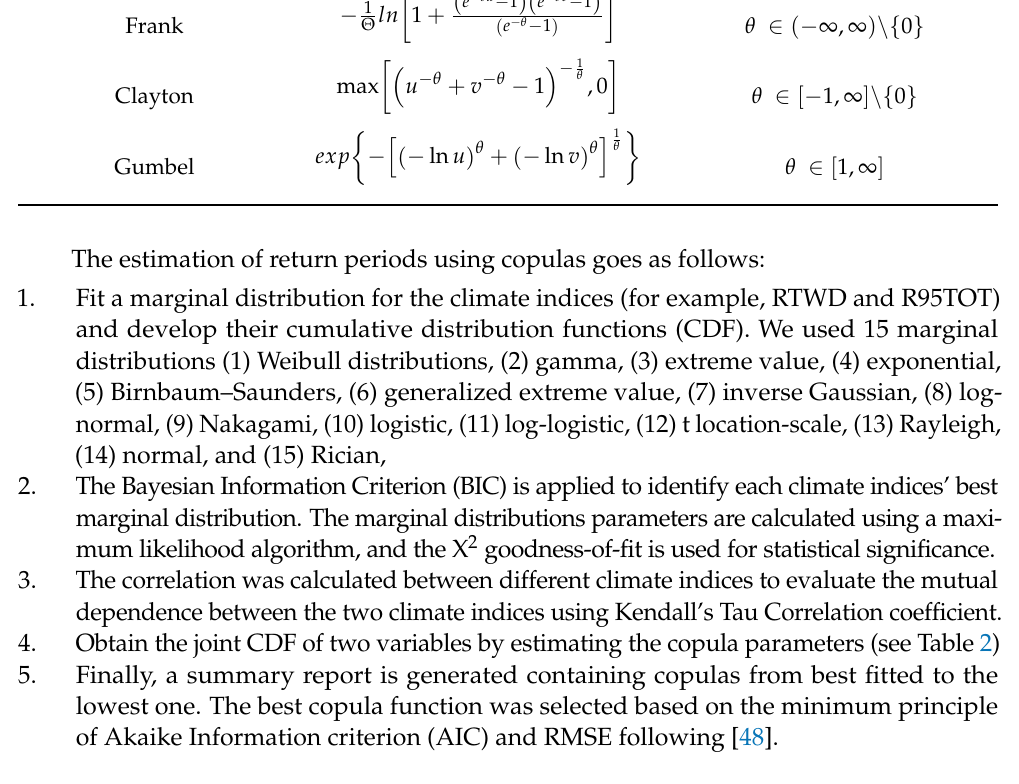
Table 2. Mathematical description of copula functions and their parameters. Copula